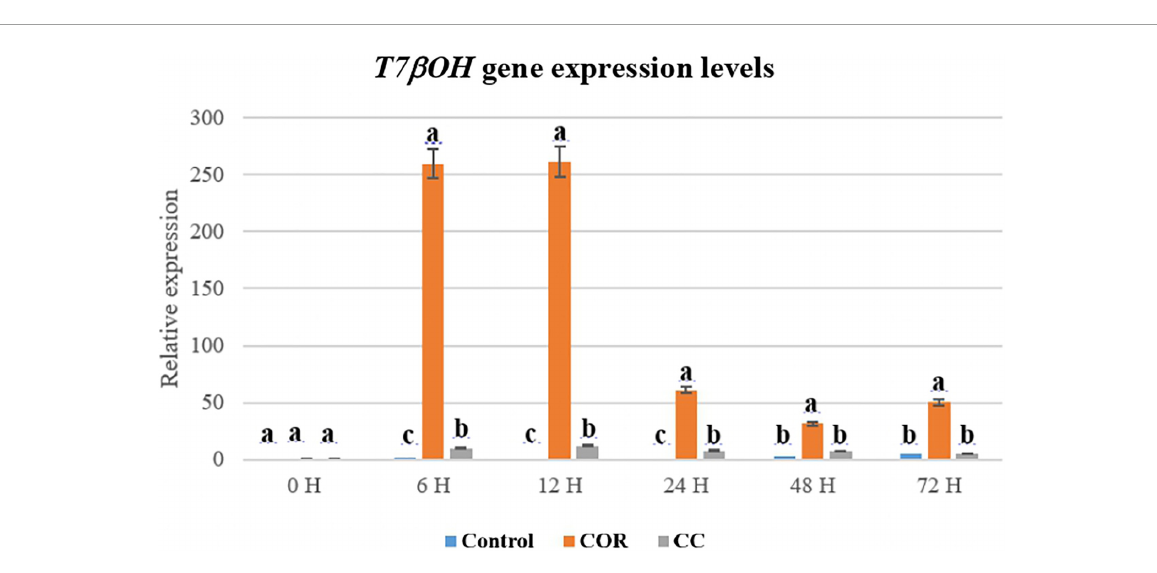
FIGURE10 Relative expression of the T7 β OH gene in T. baccata cell cultures grown in Control conditions and elicited with 1 mM coronatine (COR) or 1 mM coronatine + 50 mM methyl- β -cyclodextrins (CC). Values presented are means ± SD ( n = 3). Values followed by different letters are significantly different ( P ≤ 0.05) according to Tukey’s honestly significant difference